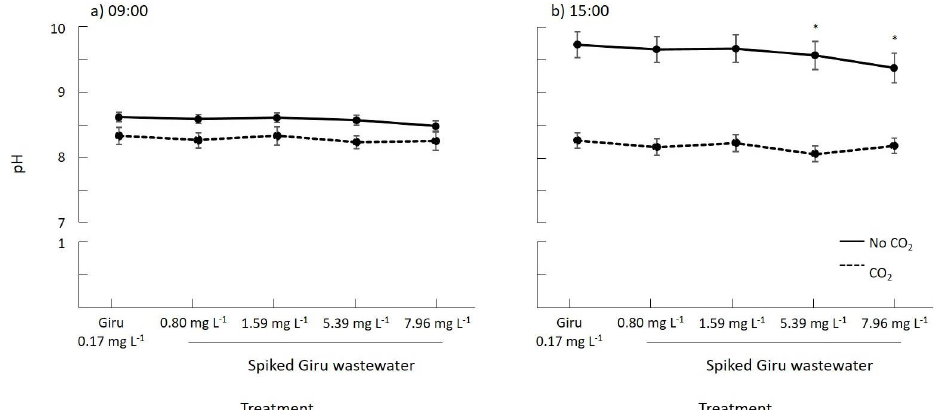
Figure 2. Mean of pH measurements in the cultivation experiments at ( a ) 09:00 and ( b ) 15:00. The pH of each culture was checked twice daily throughout the experiment and the data shown above are mean pH for each treatment over the course of the experiment. The solid line shows pH without addition of CO 2 and the dashed line shows pH with addition of CO 2 . The CO 2 treatments received a 4 s pulse of CO 2 at a flow rate of 4 L min −1 every 20 min between 09:00 and 16:00. Asterisks above treatments indicate the results of post-hoc Tukey’s test for the interaction (“CO 2 × Al”). Treatments marked with an asterisk are significantly different to the “well” treatment in that level of the interaction ( p < 0.05). All data are mean pH ± standard error ( n = 28).